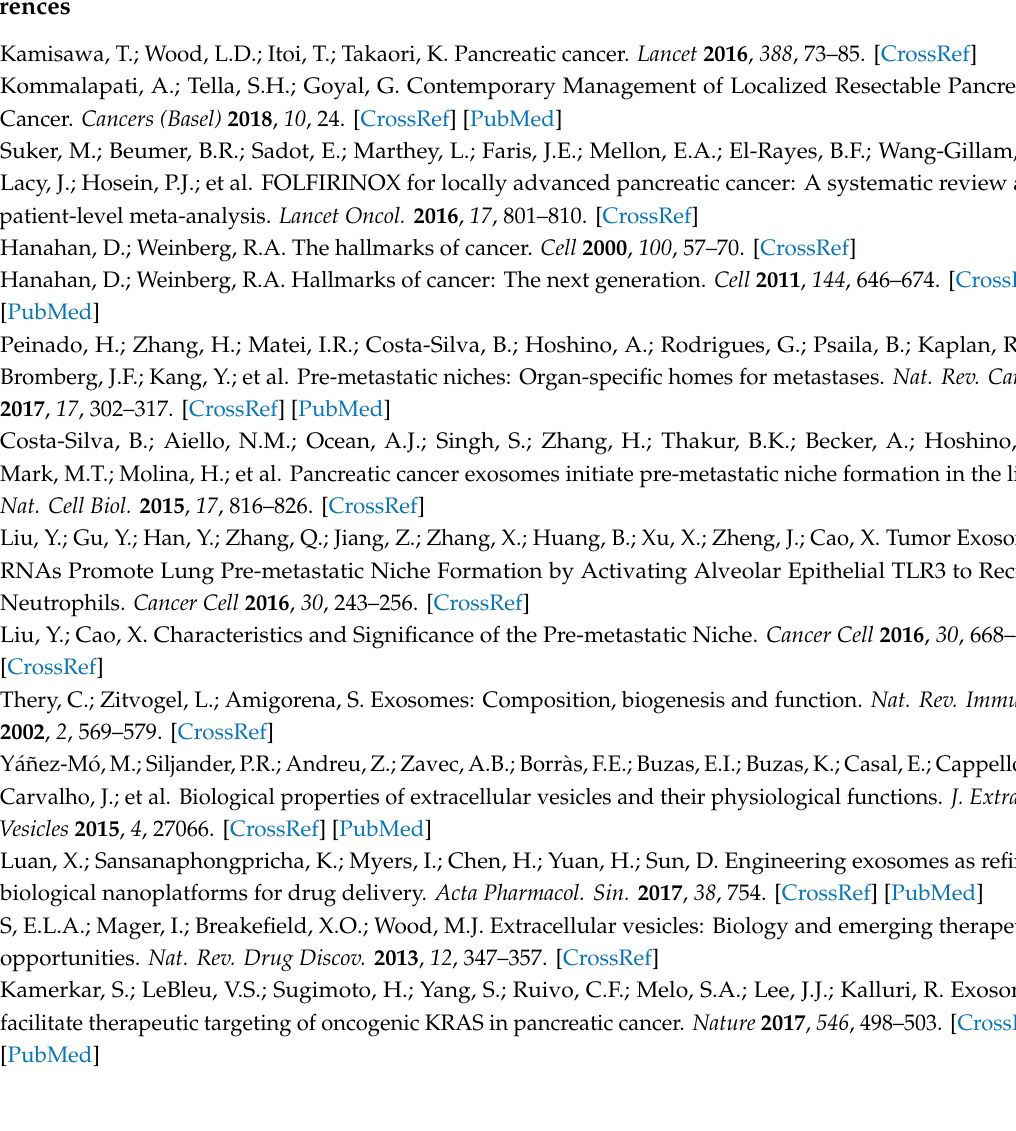
Figure S1: Isolation and analysis of pancreatic cancer-derived EVs. Figure S2: TGF- β 1 inhibits NK cell function. Figure S3: Western blot figures. Figure S4: The TEM image of pancreatic cancer-derived EVs. Figure S5: Analysis of liver injected with PBS or PKH67-labeled EVs by confocal microscopy. Table S1: The clinicopathological characteristics of patients with PDAC. Table S2: Antibodies for Western